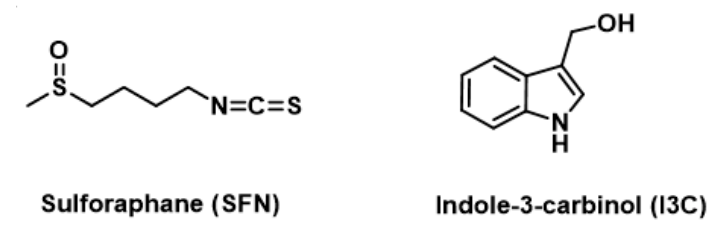
Figure 1. The molecular structures of sulforaphane and indole-3-carbinol.